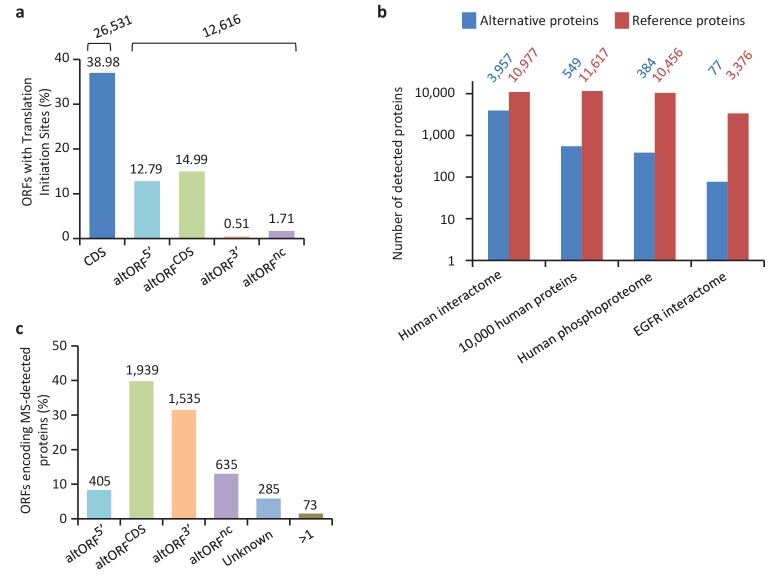
Expression of human altORFs.(a) Percentage of CDSs and altORFs with detected TISs by ribosomal profiling and footprinting of human cells (Iacono et al., 2005). The total number of CDSs and altORFs with a detected TIS is indicated at the top. (b) Alternative and reference proteins detected in three large proteomic datasets: human interactome (Hein et al., 2015), 10,000 human proteins (Rosenberger et al., 2014), human phosphoproteome (Sharma et al., 2014), EGFR interactome (Tong et al., 2014). Numbers are indicates above each column. (c) Percentage of altORFs encoding alternative proteins detected by MS-based proteomics. The total number of altORFs is indicated at the top. Localization ‘Unknown’ indicates that the detected peptides can match more than one alternative protein. Localization ‘>1’ indicates that the altORF can have more than one localization in different RNA isoforms.10.7554/eLife.27860.021Figure 5—source data 1.Expression of human altORFs.